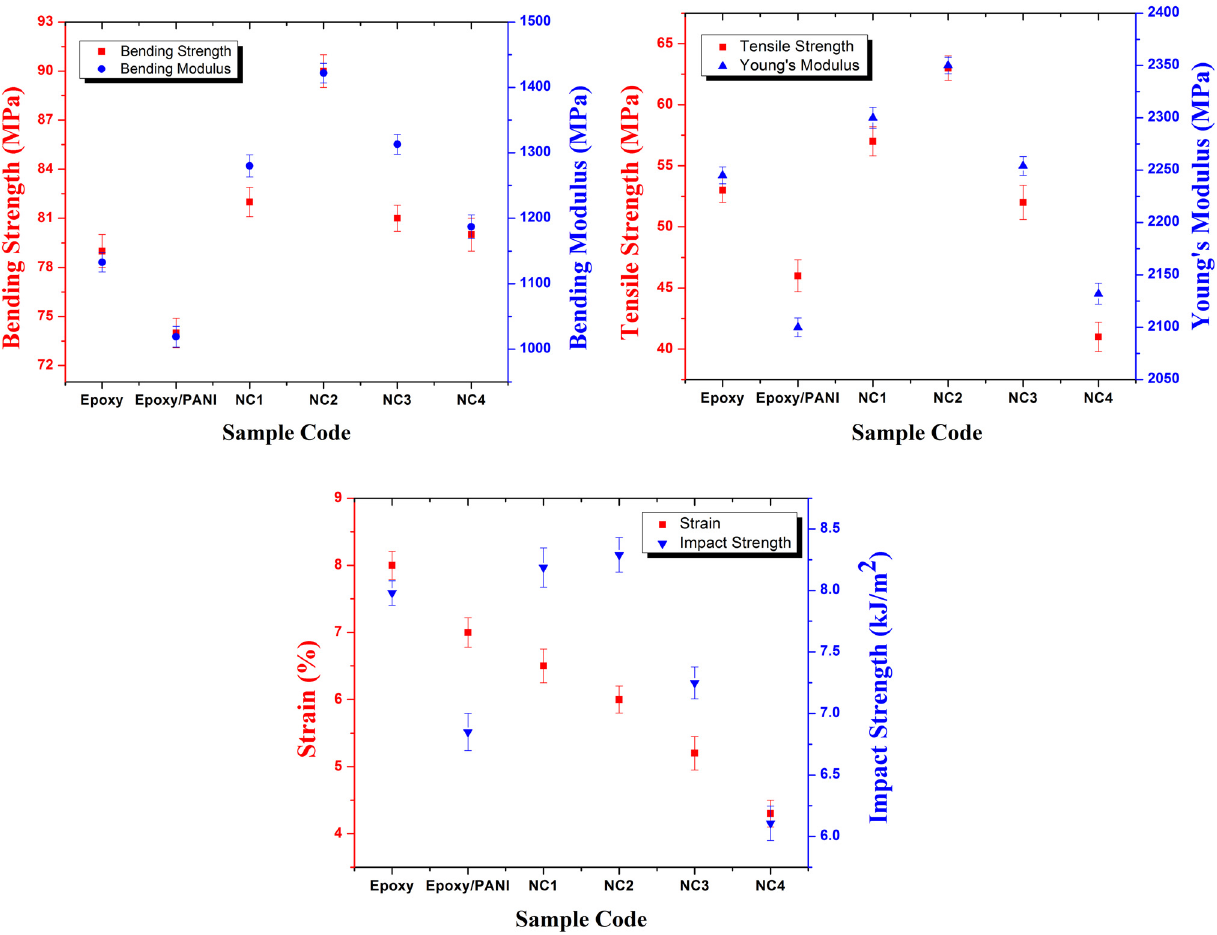
Figure 2: Mechanical properties of epoxy, epoxy/PANI, and epoxy/PANI/GNPs